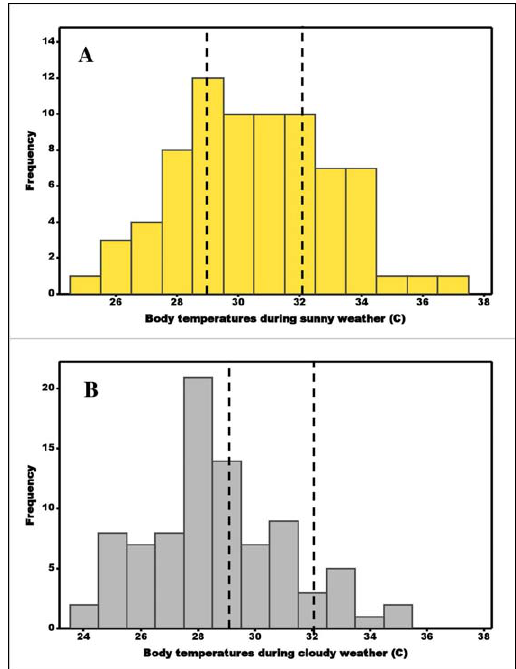
Figure 4. Body temperatures (males + females) during ( A ) sunny and ( B ) cloudy weather. Broken vertical lines represent set point temperature range for T. hermanni .